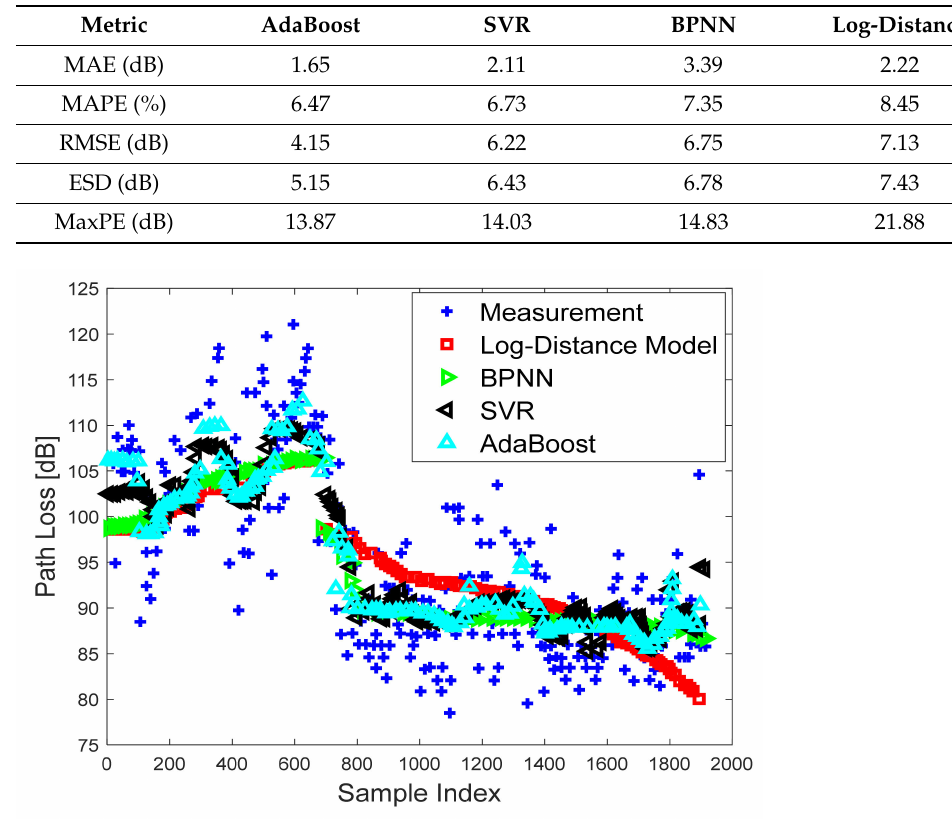
Table 3. Performance evaluation of various models using 20% test samples from OSRC (96.5 MHz) Base Station.